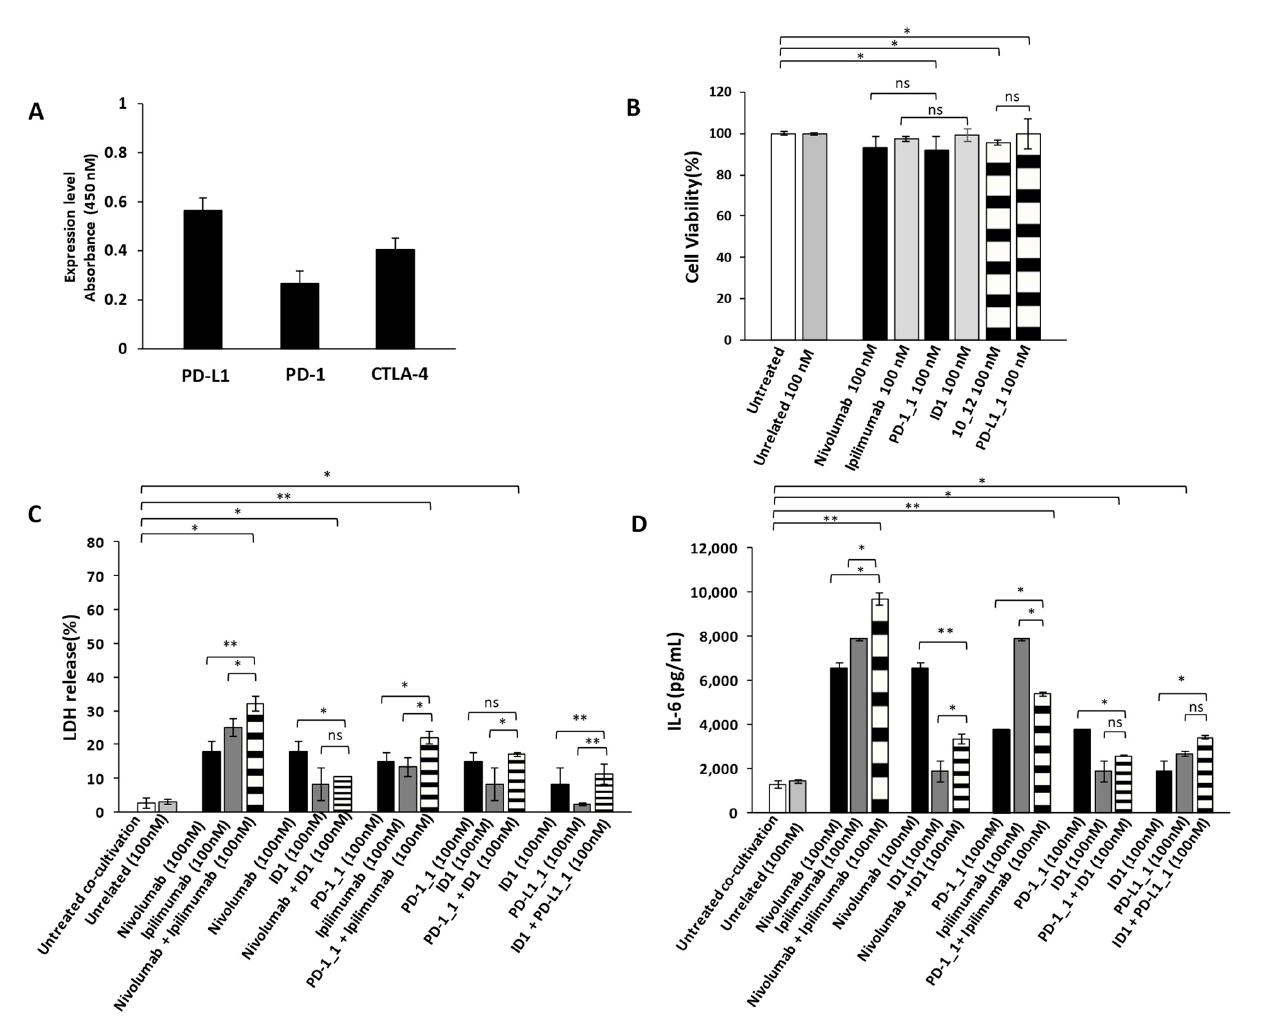
Figure 6. Cardiotoxic and pro-inflammatory effects induced by Immunomodulatory mAbs on human fetal cardiomyocytes. ( A ) Cell ELISA assay performed on HFC cardiac cells by using commercial anti-PD-1, anti-PD-L1 or anti-CTLA-4 mAbs (200 nM). ( B ) Cell viability assay on human fetal cardiomyocytes, treated for 48 h with anti-PD-1(black bars), anti-PD-L1 (striped bars) or anti-CTLA-4 (grey bars) mAbs. Cell viability is expressed as percentage of viable cells with respect to control untreated ones. Cells were counted by Trypan Blue exclusion test. ( C ) Cardiotoxic effects of immunomodulatory mAbs were analyzed by evaluating the LDH release on the supernatants of HFC cells co-cultured with hPBMCs, treated for 24 h with single mAbs (black and grey bars) or their combinations (striped bars). ( D ) Pro-inflammatory effects of immunomodulatory mAbs were analyzed by evaluating the secretion of IL-6 in the supernatant of the treated co-cultures. IL-6 is expressed as pg/mL. The values were reported as the mean of at least three determinations obtained in three independent experiments. Error bars depict means ± SD, ** p < 0.01; * p < 0.05; ns, not